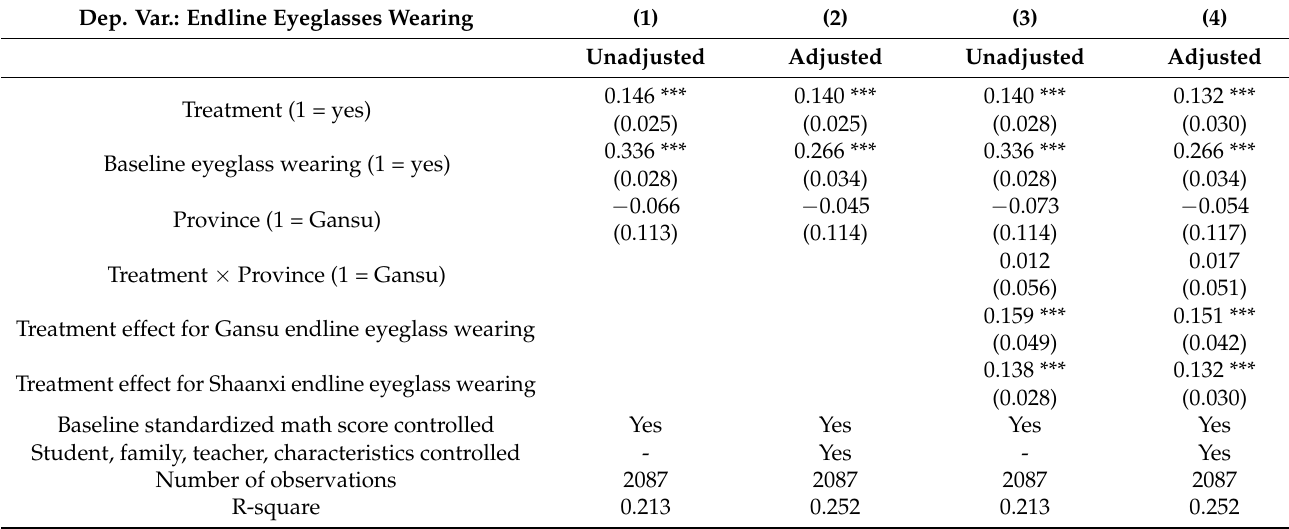
Table 4. Interaction effects of providing eyeglasses on the wearing of eyeglasses between provinces. Dep. Var.: Endline Eyeglasses